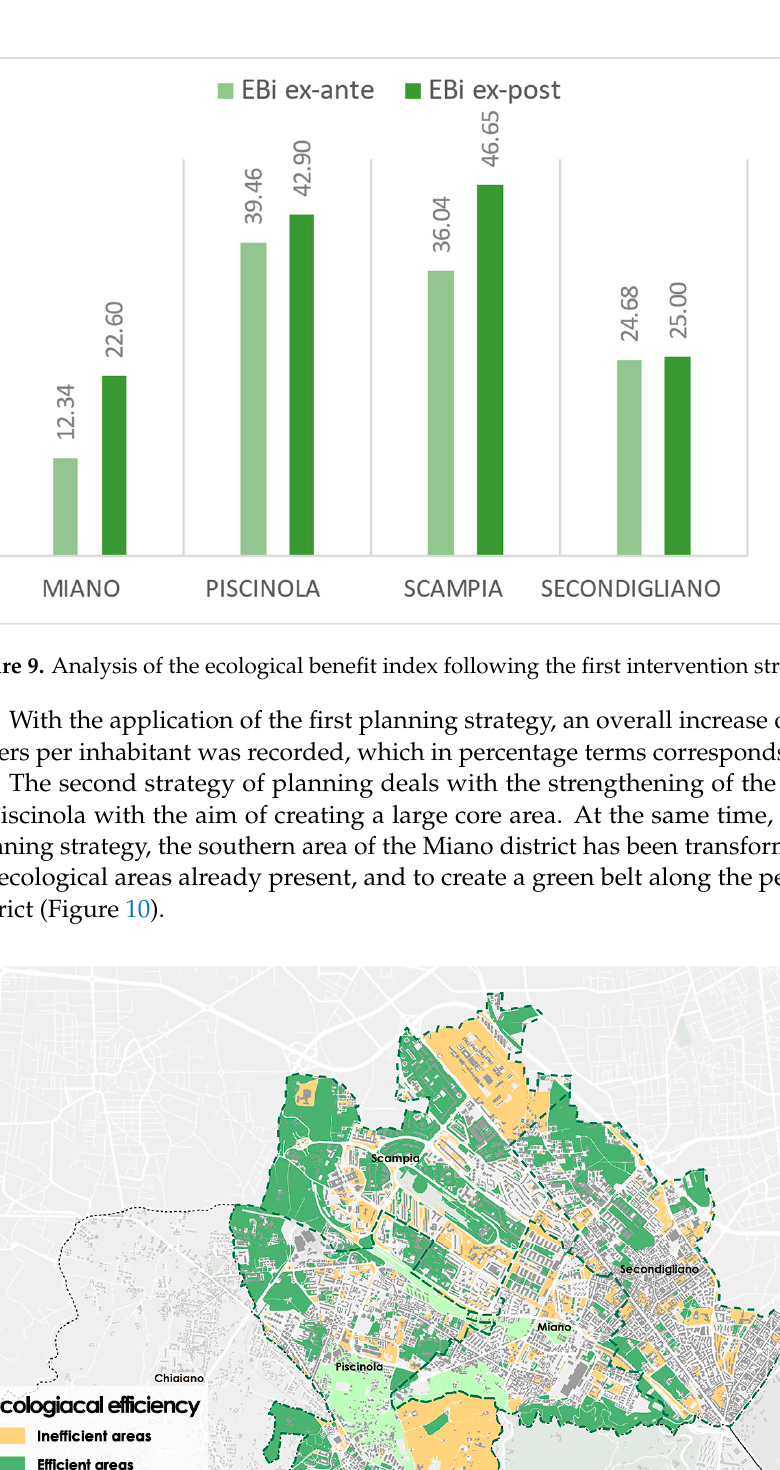
Figure 8. Distribution of ecologically efficient areas after the first intervention strategy.